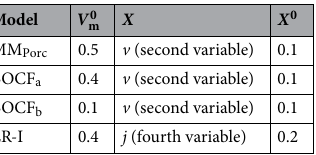
Table 4. This table lists the reference variables and their values for all investigated cell models, which are used to compute the phase in Eq (3).